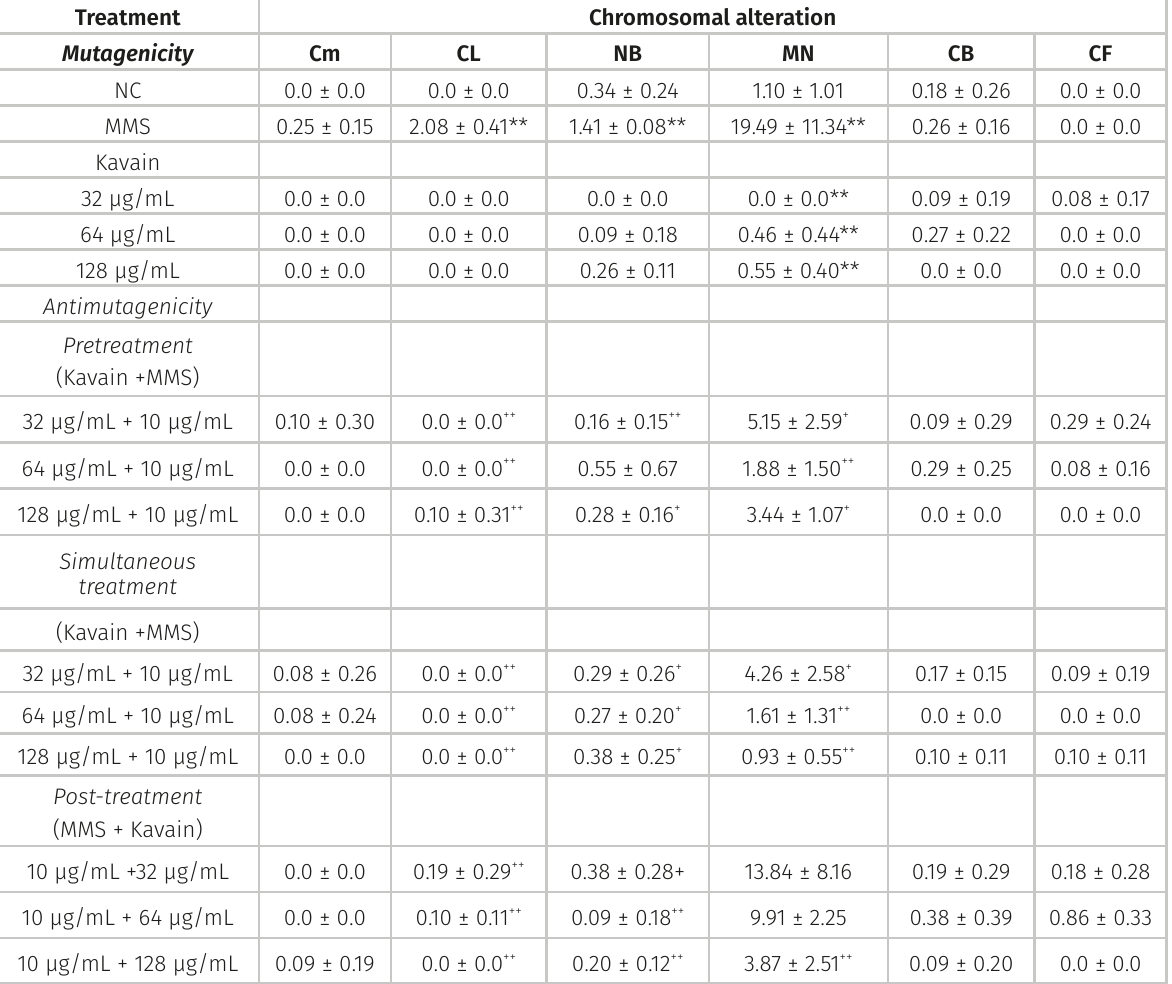
Table II. Chromosomal alterations in meristematic cells of A. cepa